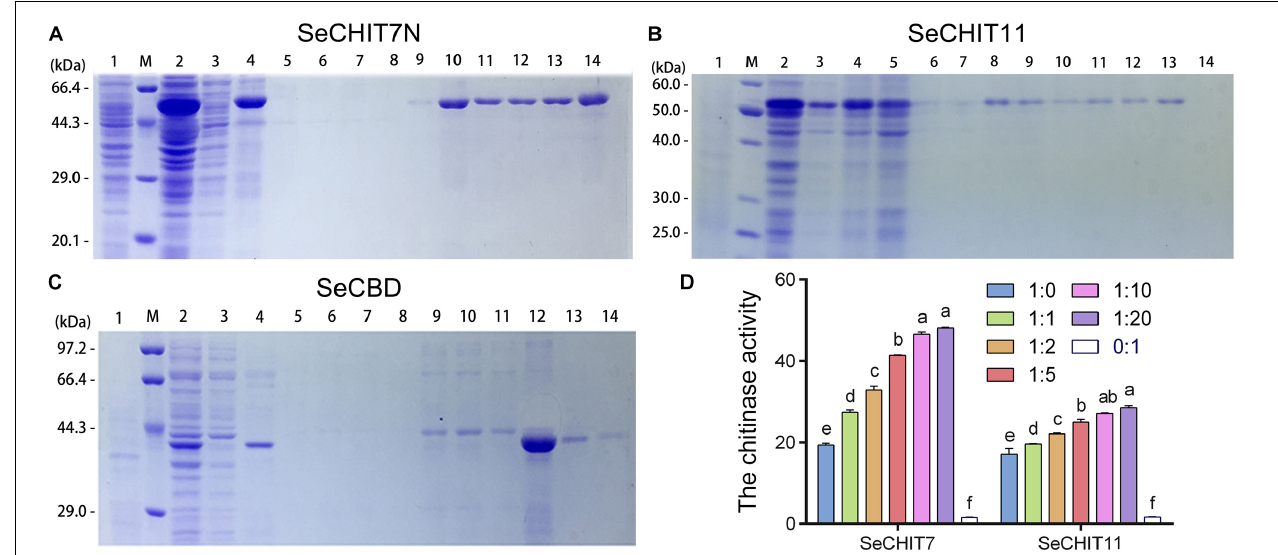
FIGURE 4 | Detection interaction of SeCHITs and SeCBD by eukaryotic expression. (A) Expression and purification of SeCHIT7N. (B) Expression and purification of SeCHIT11. (C) Expression and purification of SeCBD. (D) Chitinase activity detection of SeCHIT7N, SeCHIT11, SeCBD, and SeCHITs + SeCBD. Error bars prepresent standard